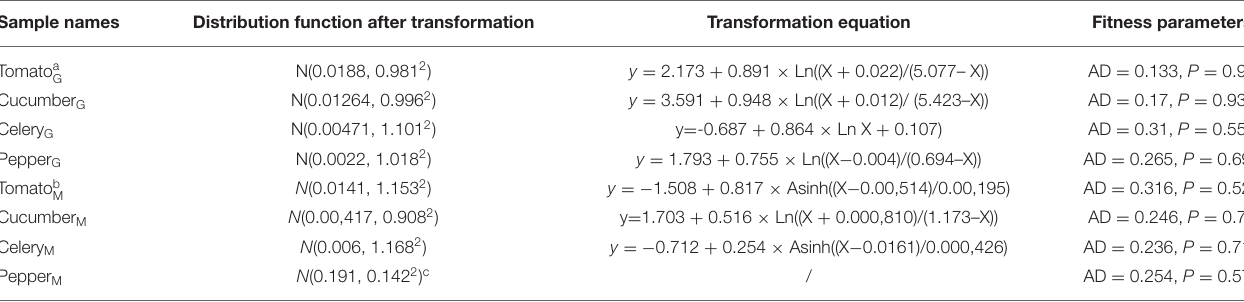
TABLE 3 | Probability distribution of chlorothalonil on different samples.